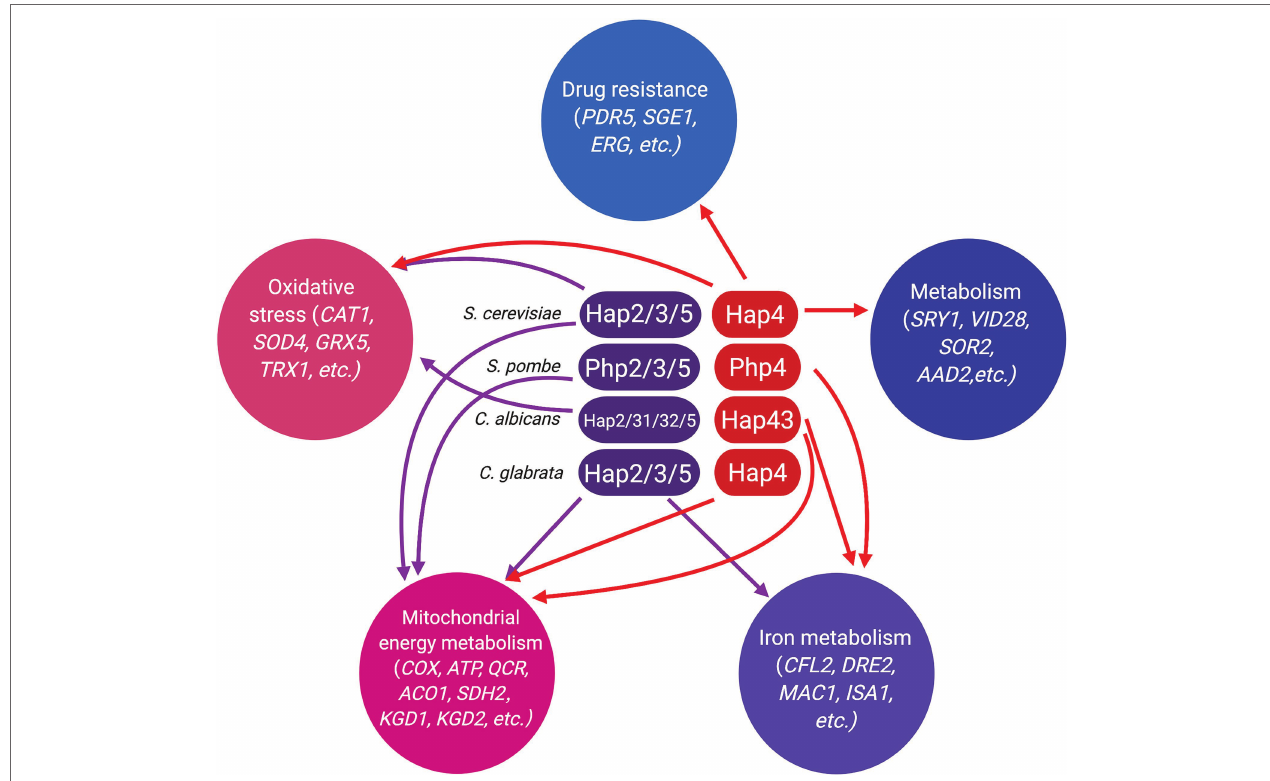
FIGURE 2 | A summary of the Hap-mediated regulation in yeasts. Genes mainly regulated by the Hap2/3/5 homolog complex are marked with purple arrows, whereas genes mainly regulated by the Hap4 homolog are marked with red